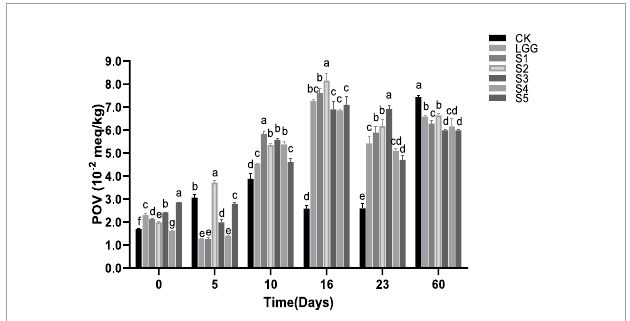
FIGURE6 Evolution of peroxide value (POV) value during the ripening of the different samples of sausage. Different letters indicate that POV values of different groups of fermented sausage have significant difference at the same time ( p < 0.05).